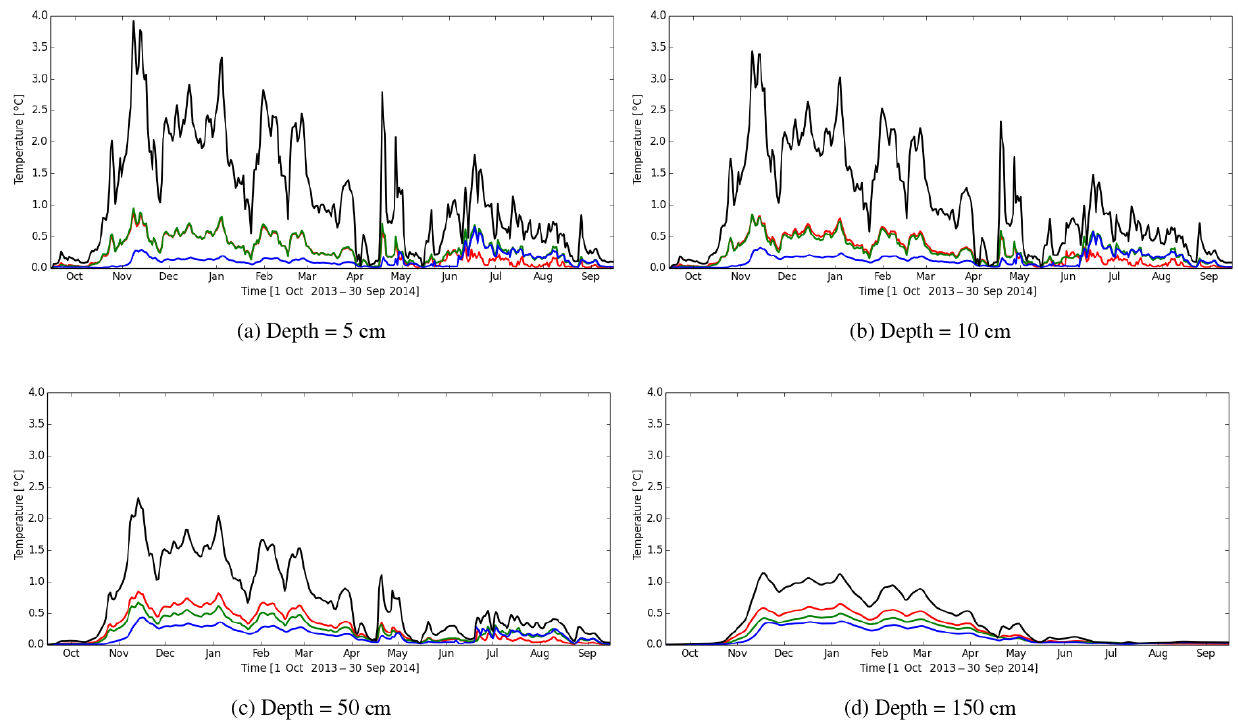
Figure E1. Spatiotemporal variability (standard deviation) in simulated soil temperature at Site B. Red, green and blue lines represent center, rim and trough respectively, and the black line represents the standard deviation across Site